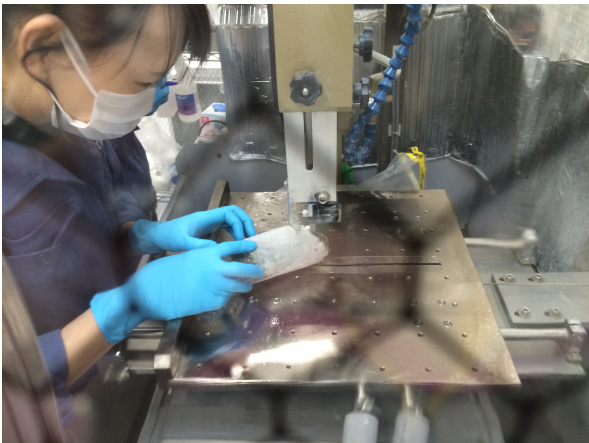
Figure 2. Example of cutting of a frozen whole-round core sam- ple with the ultraclean diamond band saw with frozen stage inside a filtered air clean booth, available at the Kochi Core Center. Pho- tograph by Beth